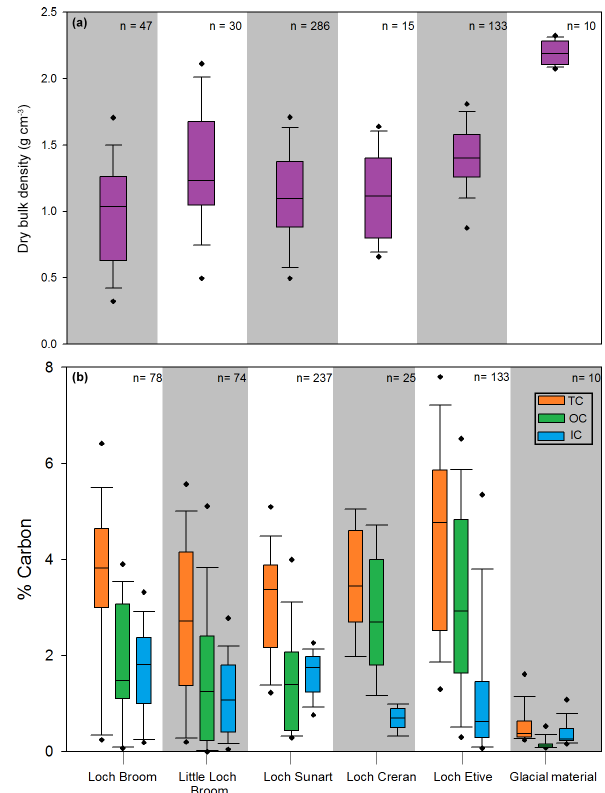
Figure 4. Box plots illustrating the (a) dry bulk density and (b) car- bon content (%) compiled from the sediment cores extracted from the five fjords central to this research. Data for the glacially derived sediments collected from Loch Sunart (MD04-2833) are also pre-